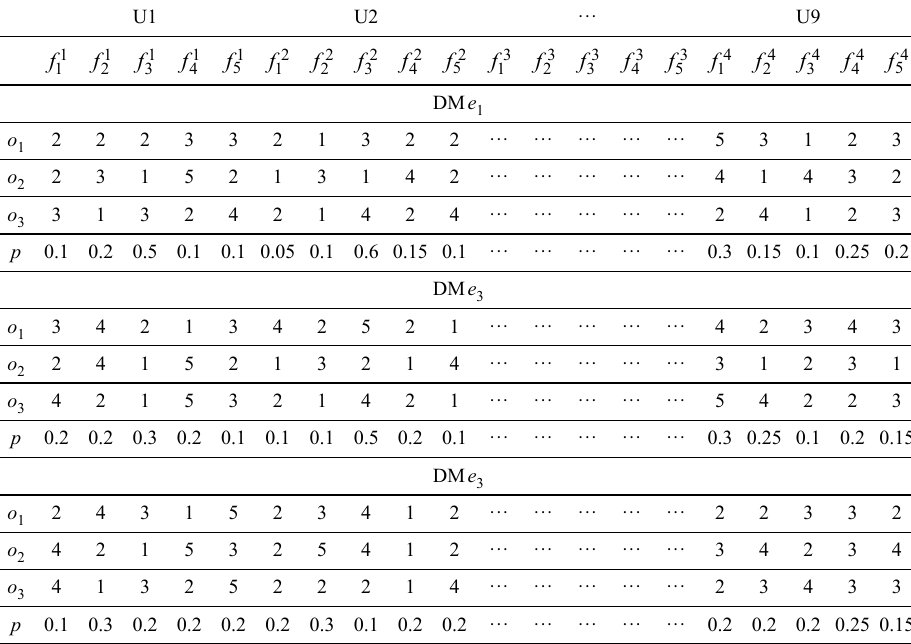
Table 2. Linguistic prospect decision